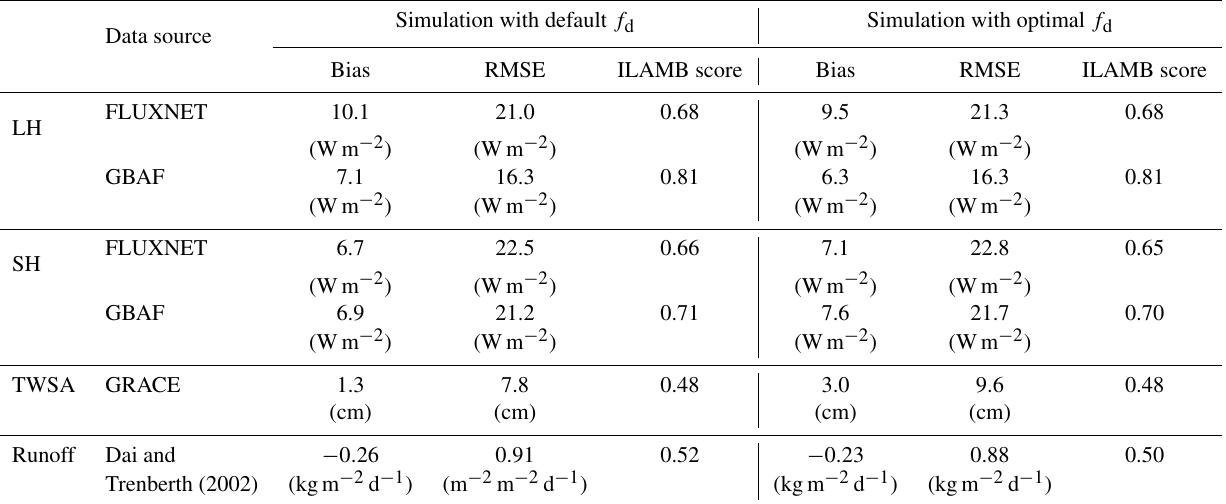
Table 3. ILAMB benchmark scores for latent heat flux (LH), sensible heat flux 640 (SH), terrestrial water storage anomaly (TWSA), and surface runoff. The calculation of ILAMB metrics and scores are described at http://redwood.ess.uci.edu/ (last access: 4 October 2018). Data